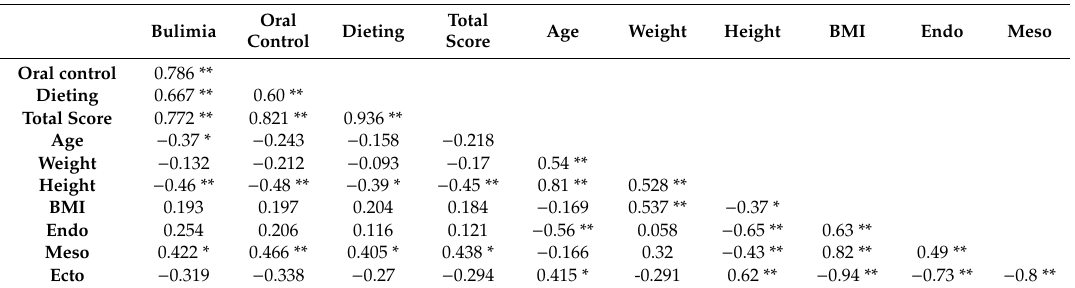
Table 2. Spearman’s rank correlation coe ffi cient between body composition variables, somatotype components and the EAT-26 subscales in the Beginner Training